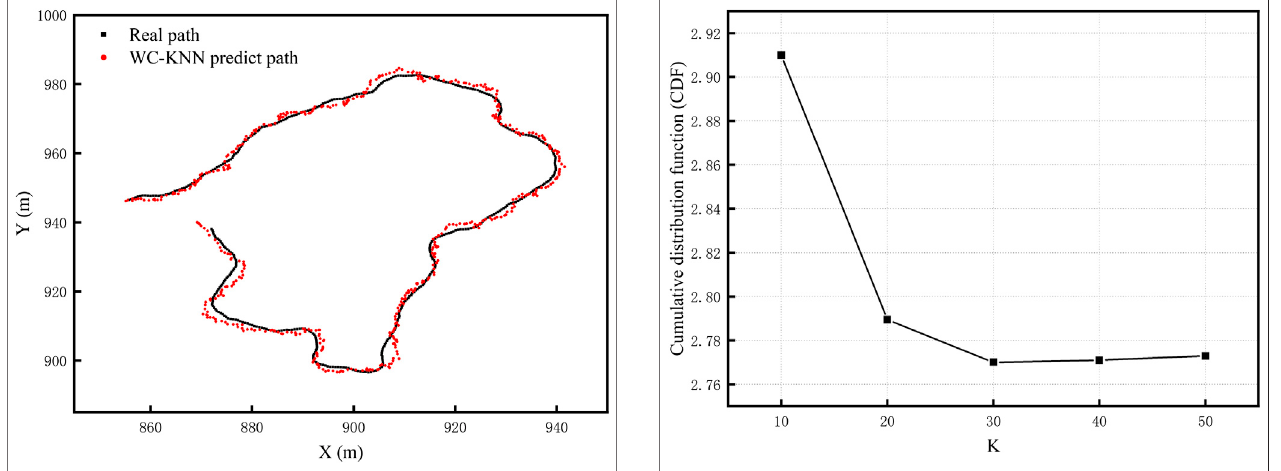
FIGURE 6 | When K < 20, the positioning error dropped rapidly, and whenK (cid:1) 20,itenteredarelativeconvergencestage.WhenK (cid:1) 30,theoverall positioning performance was the best. When K continued to increase, the classi fi cation of positioning nodes was affected.